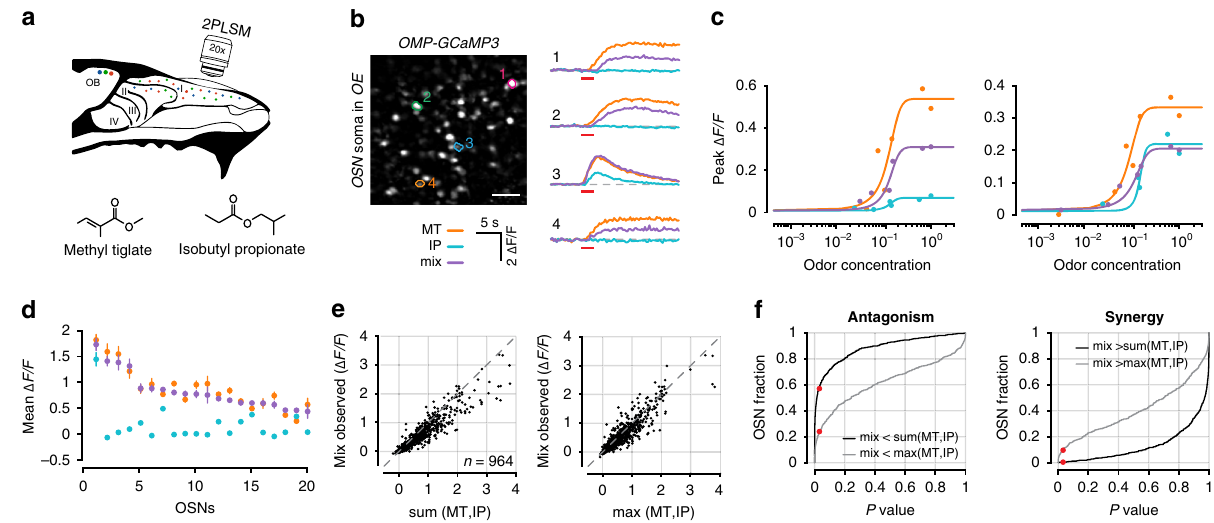
Fig. 6 Antagonism in individual sensory neurons. a Experimental setup for imaging OSN somata in the epithelium. b Example image of OSN somata and selected ROIs from one of six mice. Odor responses for two odors (Methyl tiglate and Isobutyl propionate) and a mixture of both odors from selected OSNs are shown on right as Δ F/F time courses. Red bar under traces denotes odor delivery time. Scale bar in image is 30 µ m. c Example dose response curves from two selected OSNs. Each point is the average of 3 – 5 trials. d Data from 20 randomly selected OSNs. Each point is the mean response of the three highest odor concentrations for each odor. Error bars are SEM. e Left, scatter plot of the observed mixture response against the linear sum of both mixture components or (right) against the maximum response generated by either mixture component. f Left, cumulative distribution of one-sided rank-sum P values obtained for 964 OSNs for linear sum comparison (black) and comparison to maximum component response (grey). Red dots mark P values < 0.05. Right, cumulative distribution of left-sided rank-sum P values for linear sum comparison (black) and comparison to maximum component response (grey) to identify synergistic mixture